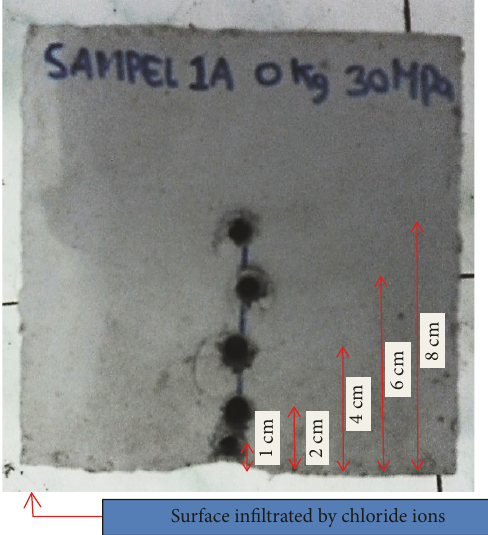
Figure 4: Drilling depth from the unprotected surface by the coating system.